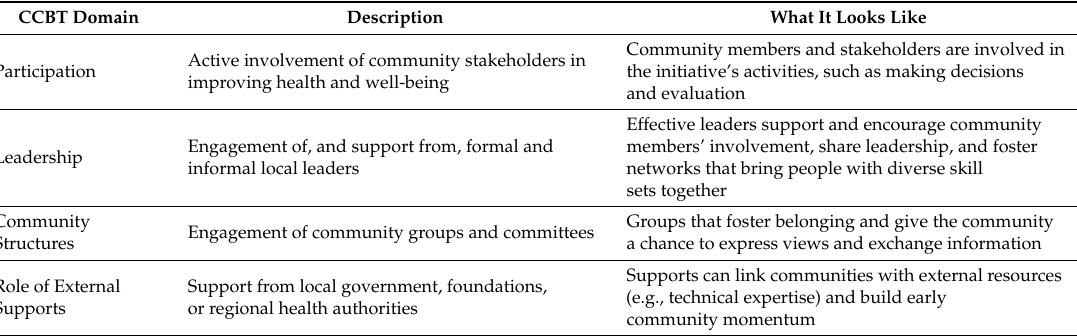
Table 2. Domains assessed by the CCBT